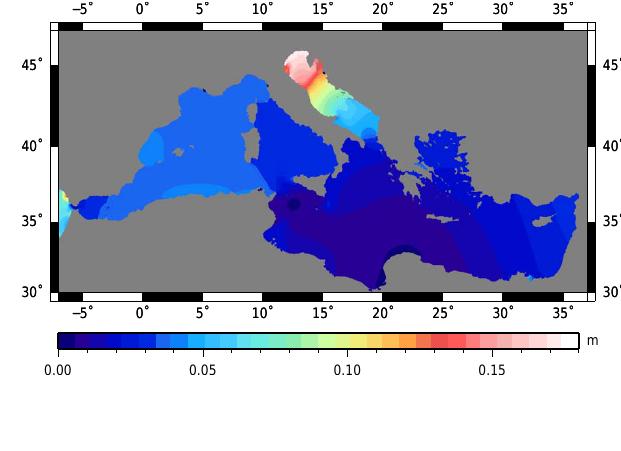
Fig. 8. Amplitude of the K1 constituent.